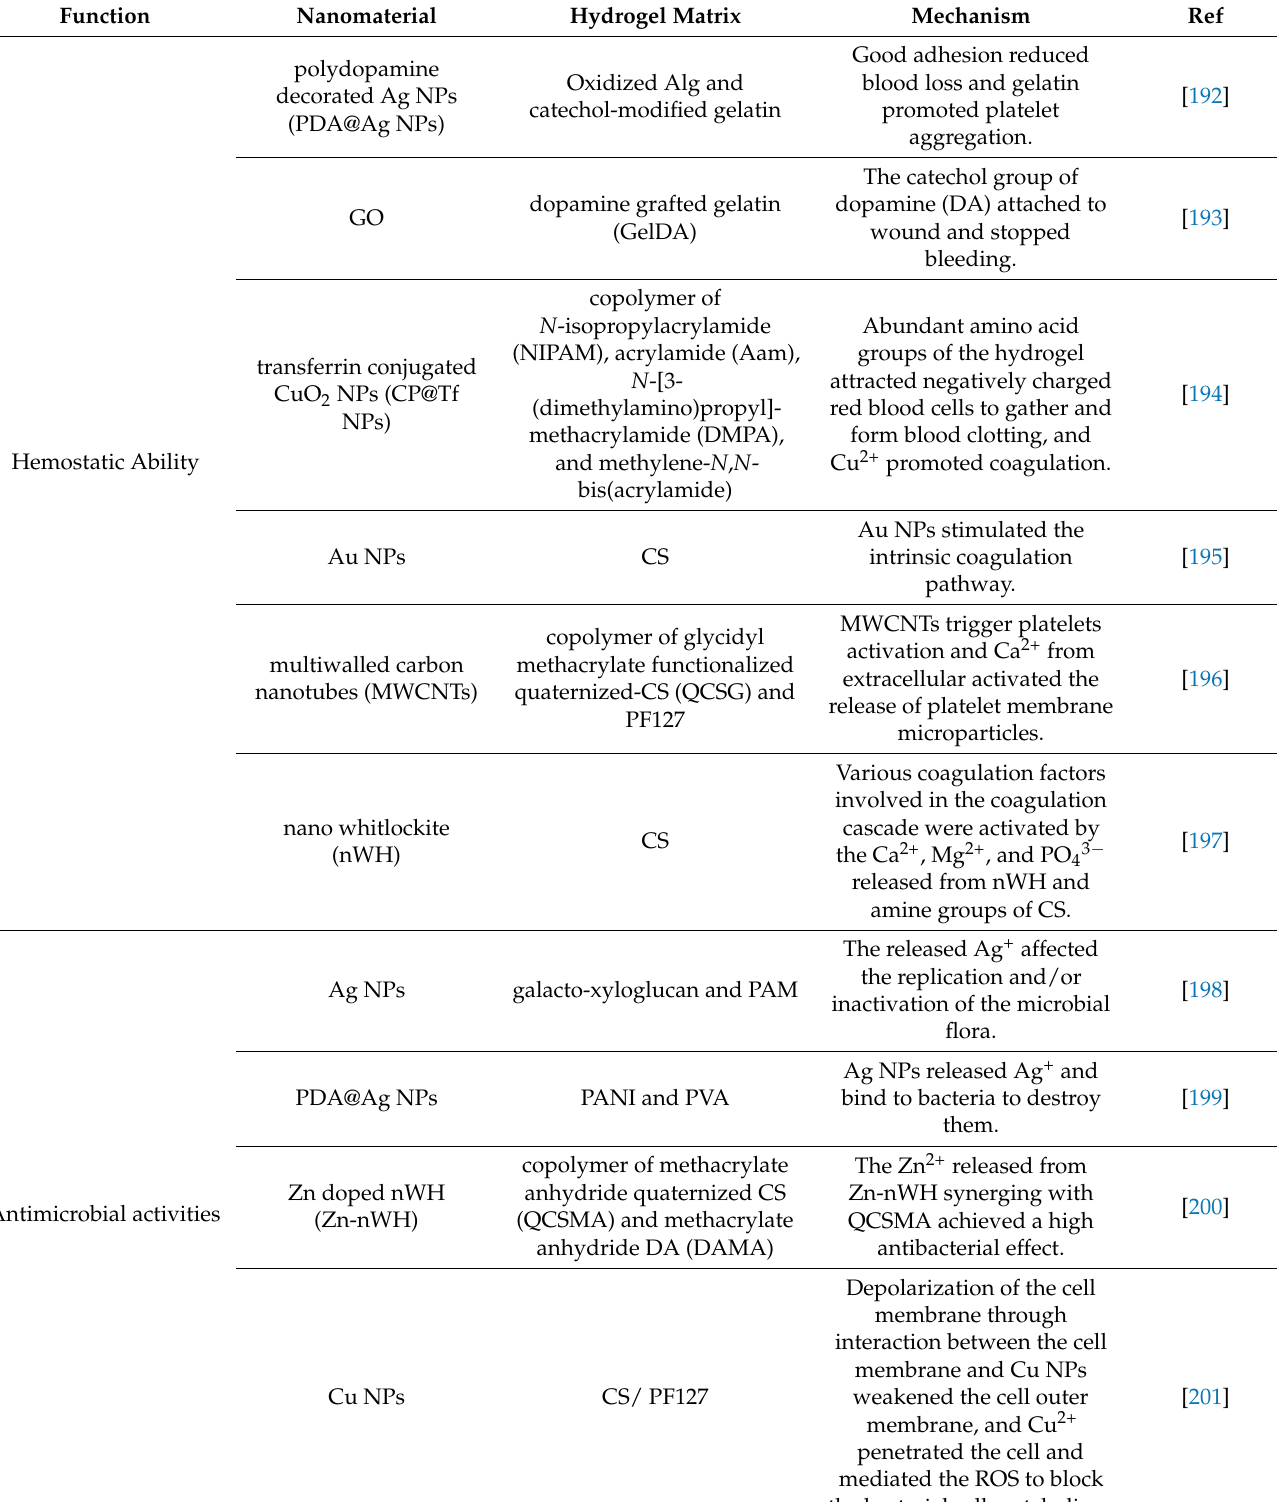
Table 1. Summary of other NMFHs with different